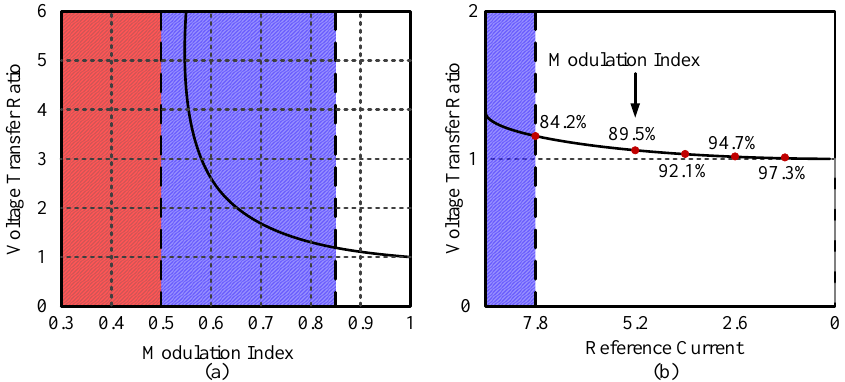
Figure 8. The voltage transfer ratio to the variation of ( a ) the modulation index; ( b ) the reference current and modulation index.